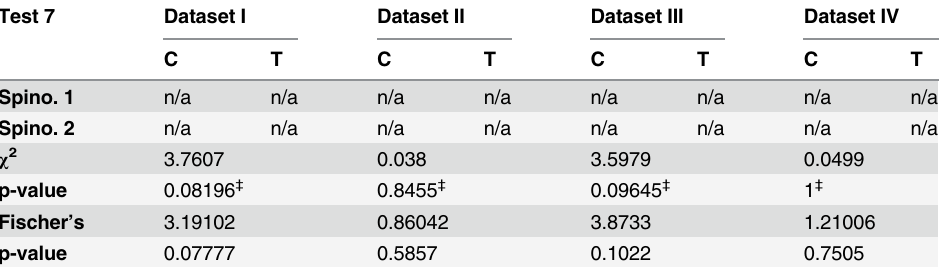
Table 8. Results of Chi-square Test 7 as presented by software R.